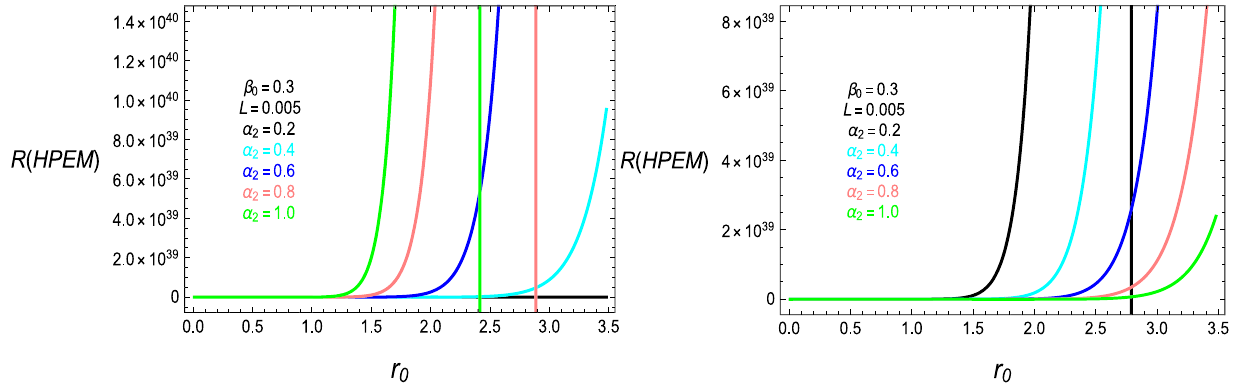
Fig. 6 Portray the graphical behavior of H E PM geometry by choosing β 0 = 0 . 3 , L = 0 . 005 , α 2 = ( 0 . 2 , 0 . 4 , 0 . 6 , 0 . 8 , 1 . 0 ) {left} and α = 0 . 8 , L = 0 . 005 , β = ( 0 . 3 , 0 . 5 , 0 . 7 , 0 . 9 , 1 . 1 ) 2 0